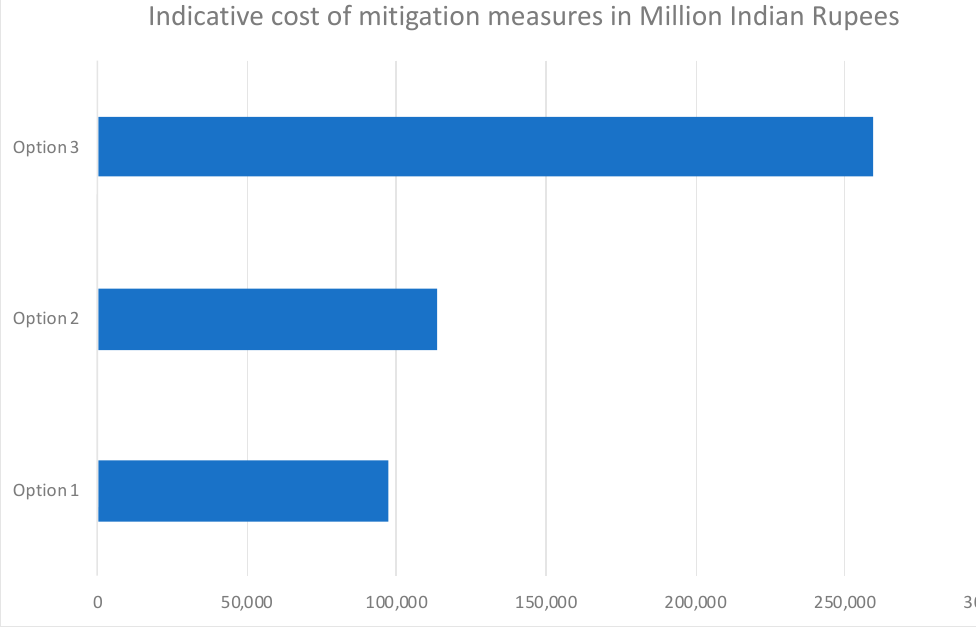
Table 1. Total Damage and Damage to Power Sector by Cyclones (in INR crores).